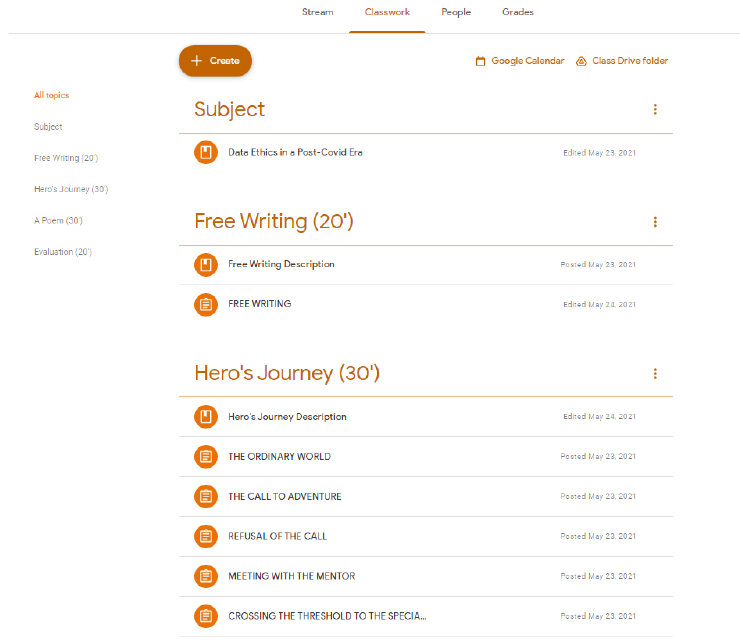
Figure 2. Google Classroom, classwork (first part).